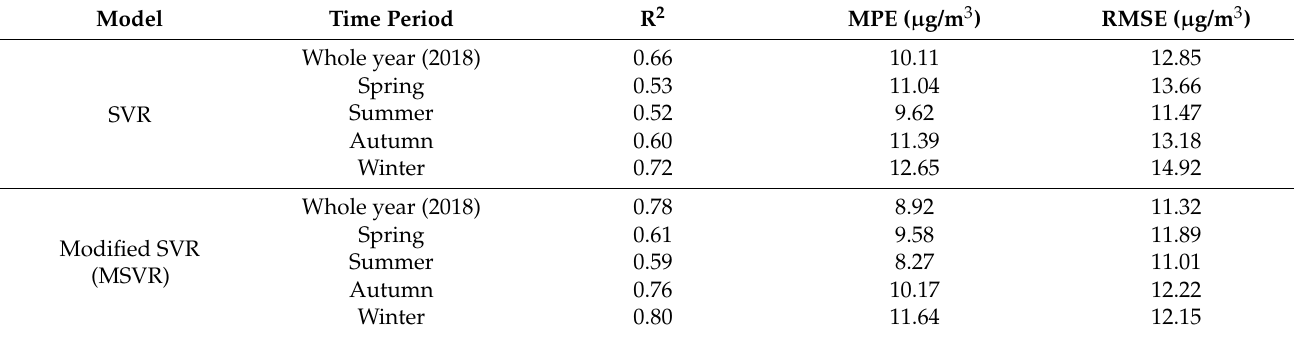
Table 5. Accuracy comparisons between SVR and MSVR for different seasons and the entire year in 2018.